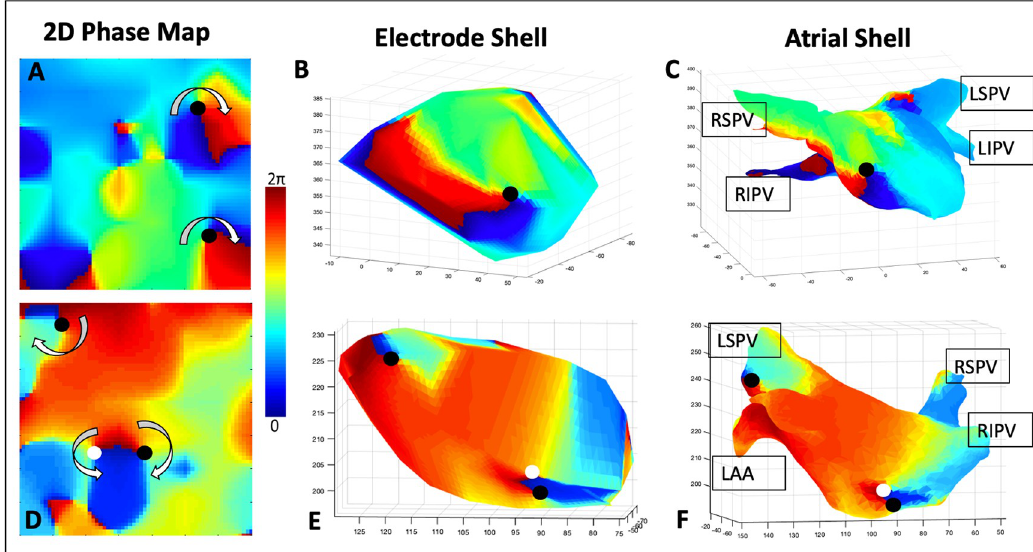
Fig 2. Phase maps features are conserved between 2D and 3D. (A) Snapshot of the 2D phase map in a 56 year old man with persistent AF showing a clockwise and counterclockwise rotational circuit. The phase singularities, corresponding to the tips of the spiral waves, are labeled in black (clockwise) and white (counterclockwise). (B) 3D electrode phase map corresponding to the timepoint in (A), showing the two rotational patterns seen in the 2D map. (C) Phase map projected onto the patient-specific anatomical atrial shell, along with the location of the spiral wave tips. (D-F) as in (A-C) showing three rotational circuits in a 71 year old man with persistent AF. (RSPV: Right superior pulmonary vein, RSPV: Right inferior pulmonary vein, LAA: Left atrial appendage, LPVs: Left pulmonary veins, LSPV: Left superior pulmonary